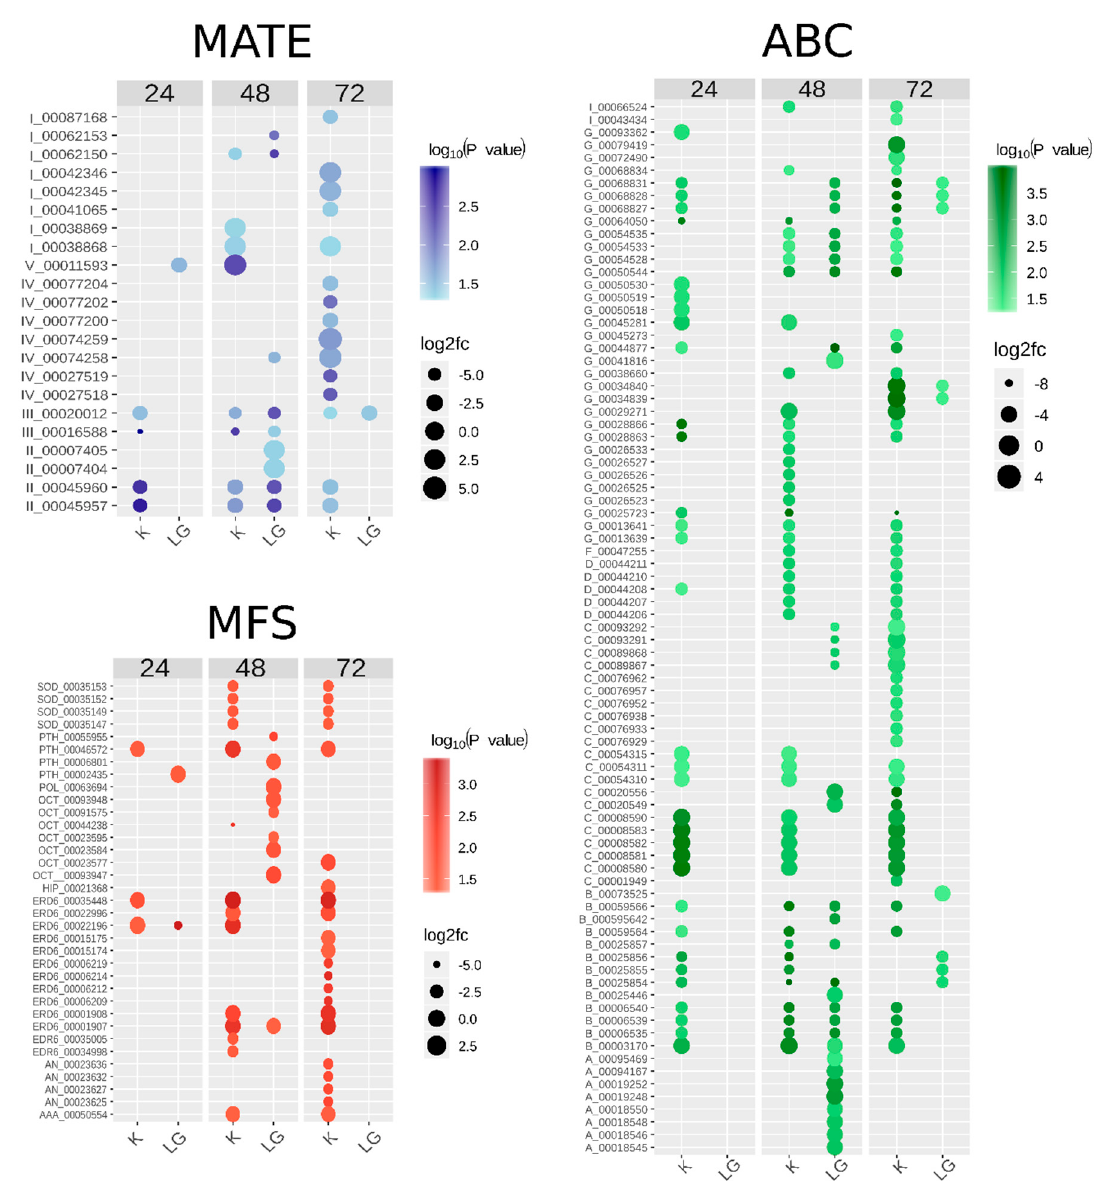
Figure 7. Bubble chart of MATE, ABC, and MFS transcripts differentially expressed in response to Xac infection in 24, 48, and 72 hours after bacterial inoculation. K: ‘Kumquat’, LG: Acid Lime ‘Galego’. The color of markers represents the − log 10 ( p -value) values and the size is proportional to the log 2 FC values. The identification of each transcript is given by the abbreviation of its respective subfamily followed by its identification number in the CRT.